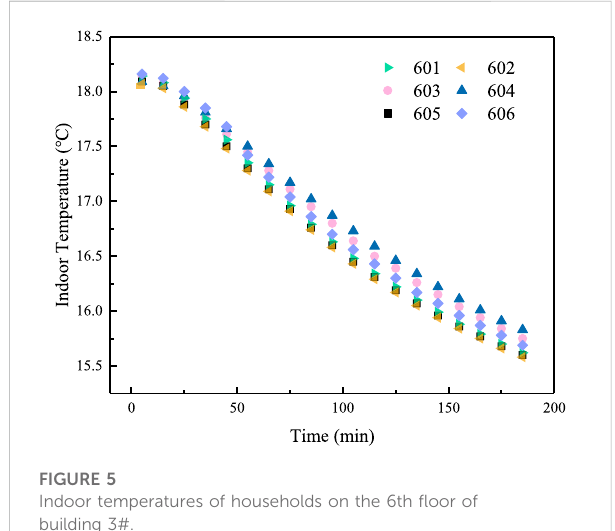
FIGURE 5 Indoor temperatures of households on the 6th fl oor of building 3#.